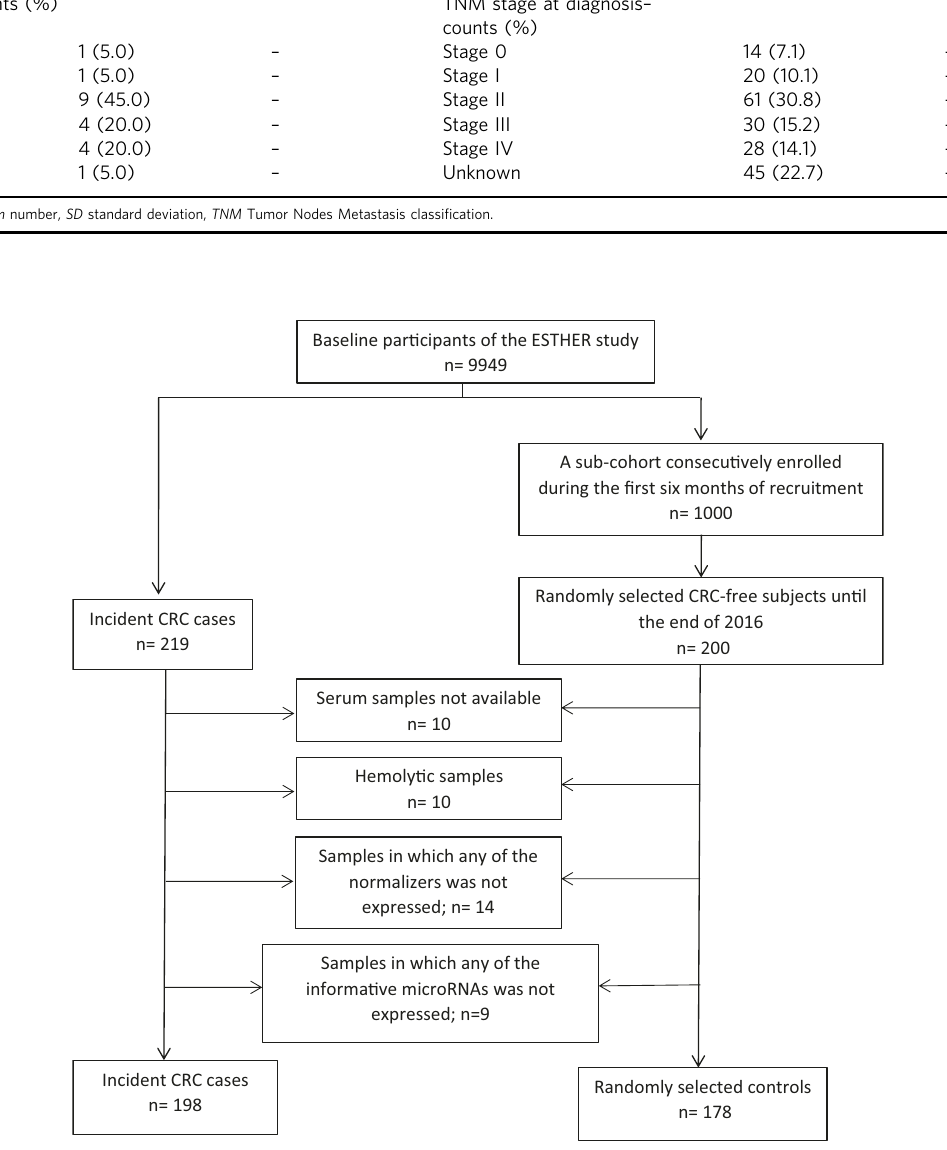
Fig. 1 Flow diagram for selection of prospective set participants. CRC colorectal